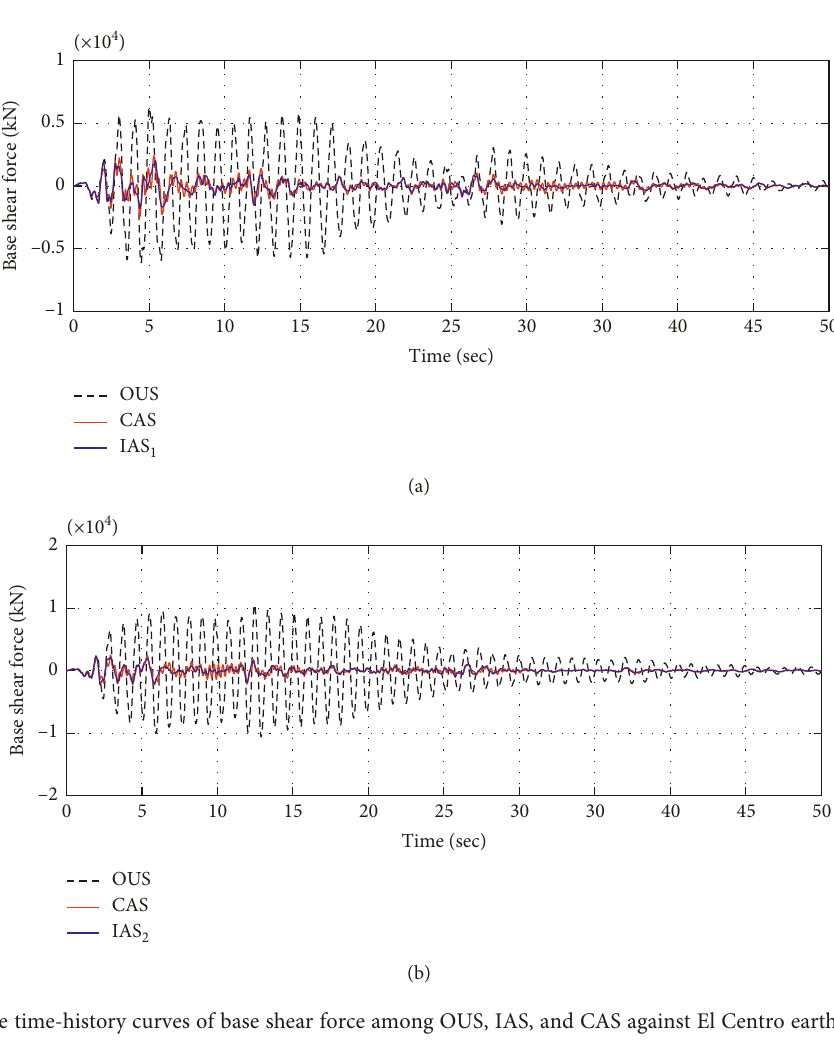
Figure 6: Comparative time-history curves of base shear force among OUS, IAS, and CAS against El Centro earthquakes. (a) Building 1. (b) Building